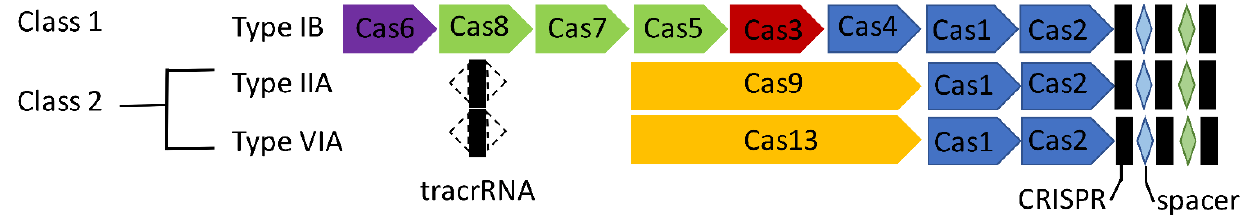
Figure 2. Composition of CRISPR types identified in Listeria. Colors here indicate distinct functional roles found in Figure 1.